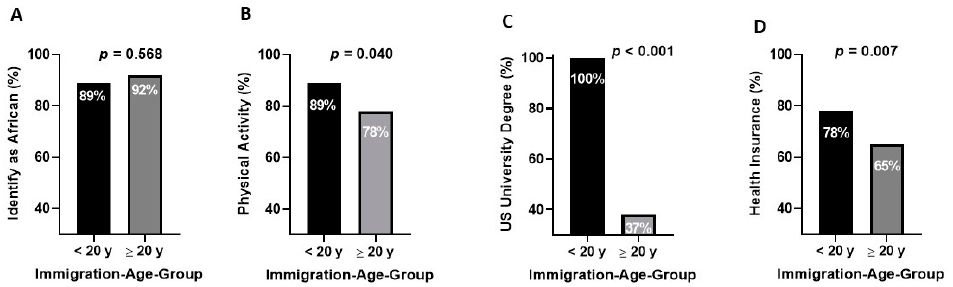
Figure 3. Comparison by Immigration-Age-Group of Key Cultural and Socioeconomic Factors. Black columns represent the Immigration-Age < 20 y group. Grey columns represent the Immigration-Age ≥ 20 y group. ( A ): Self Identify as African; ( B ): Physical Activity; ( C ): Degree from a university in the United States; ( D ): Health Insurance.